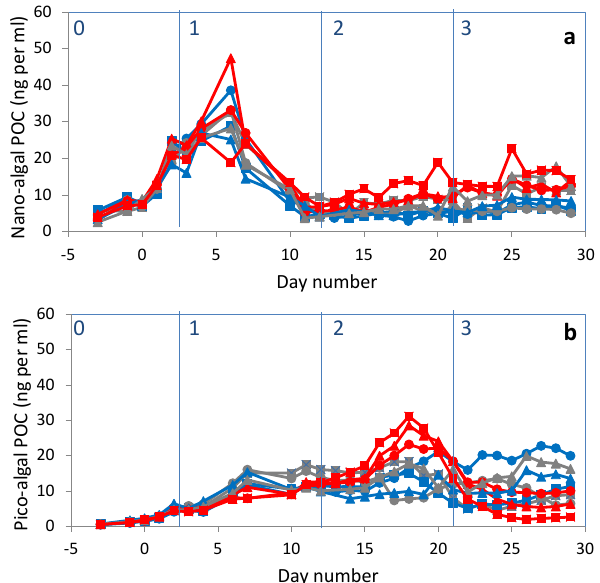
Fig. 2. Temporal development of algal particular organic carbon (POC) for total nanophytoplankton ( (a) Nano-algal POC) and pico- phytoplankton ( (b) ; Pico-algal POC). For color and symbol coding, see Fig.